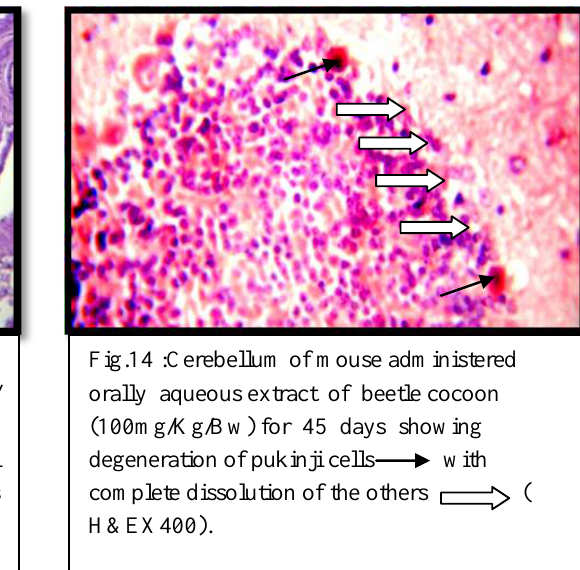
Fig.13: Liver of mouse administered orally aqueous extract of beetle cocoon (100mg / Kg/ Bw) for45 days showing moderate prebiliary